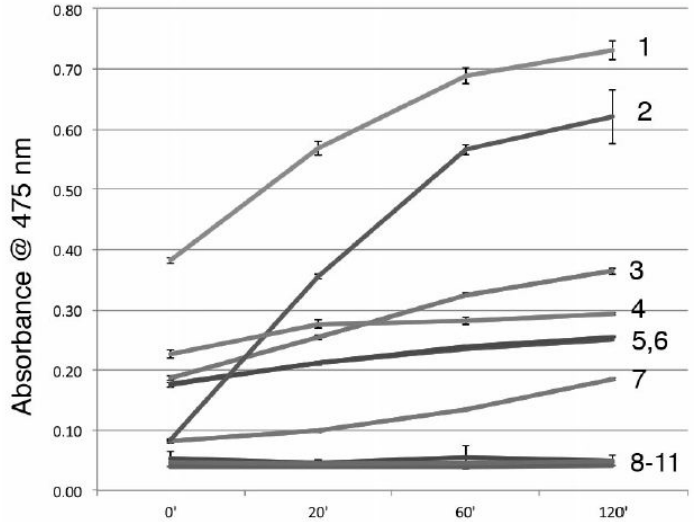
Figure 6. In vitro tyrosinase assay. Reaction containing L-tyrosine and tyrosinase with or without skin-lightening compounds were set up in triplicate in a 96-well plate. The absorbance at 475 nm were taken at 20 ′ , 60 ′ and 120 ′ . Several known skin-lightening compounds ( 8 – 11 ) showed strong tyrosinase inhibition, as the absorbance stayed near zero, including arbutin, kojic acid (KA), PTU, and niacinamide (Nia). However, A11 ( 5 ) and MEK-I ( 4 ) did not show any inhibition of tyrosinase at all as the tyrosinase functioned like in H 2 O ( 6 ).